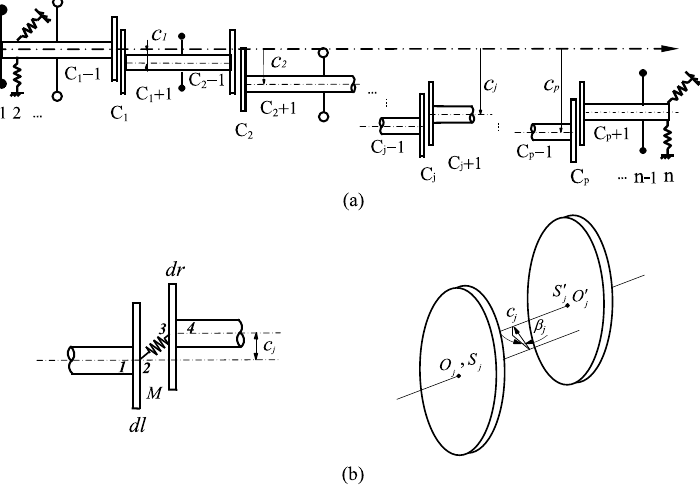
Fig. 2. Schematic diagrams of a misaligned rotor for (a) the global offset, and (b) the con fi guration of